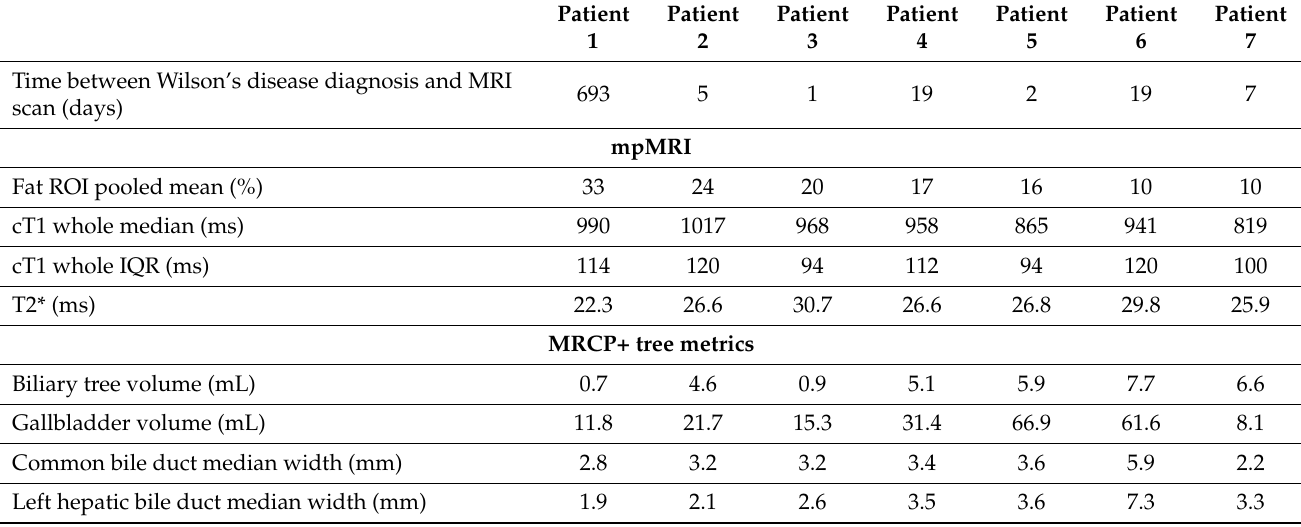
Table 3. Quantitative multiparametric MRI and quantitative MRCP results per